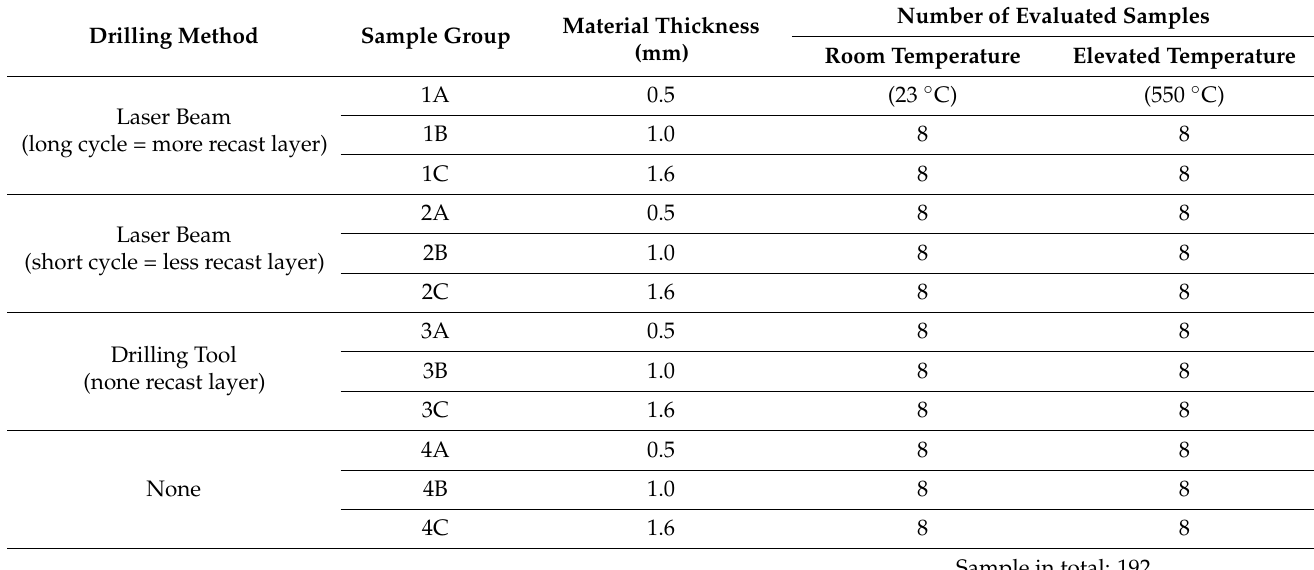
were four Sample Groups (1 through 4) including all three material thicknesses (A through C). Table 2. All the sample groups and the total number of experimental